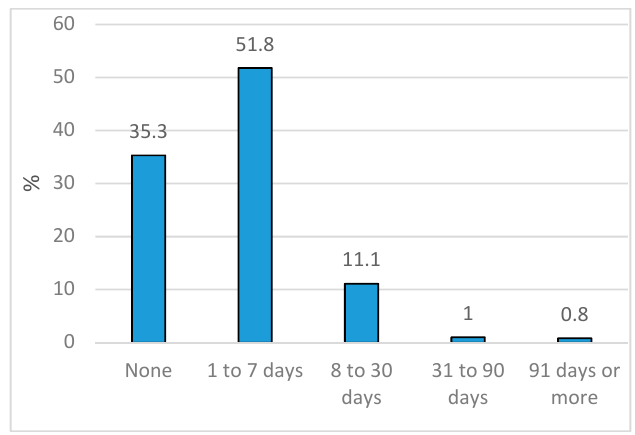
Figure 1. Distribution of presenteeism (days of going to work despite one should have reported in sick) in the study sample (SLOSH) 2008 ( n = 7661).